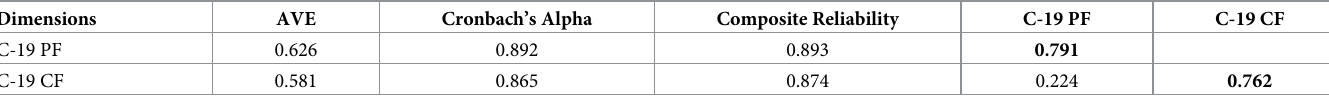
Note. The bold number is the square root of AVE. The bold numbers listed diagonally are the square root of the variance shared between the constructs and their measures. The off-diagonal elements are the correlations among the constructs. For discriminate validity, the diagonal elements should be larger than the off-diagonal